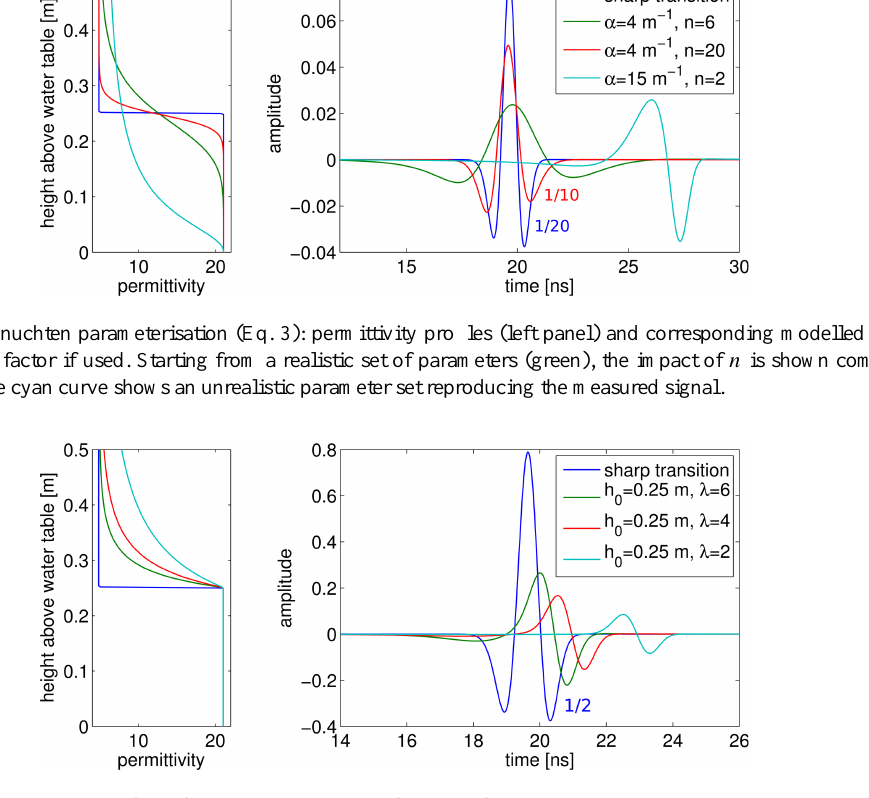
Fig. 6. Brooks–Corey parameterisation (Eq. 4): permittivity profiles (left panel) and corresponding modelled reflections (right panel) with amplification factor if used. λ is changed while keeping h 0 constant compared to a sharp transition